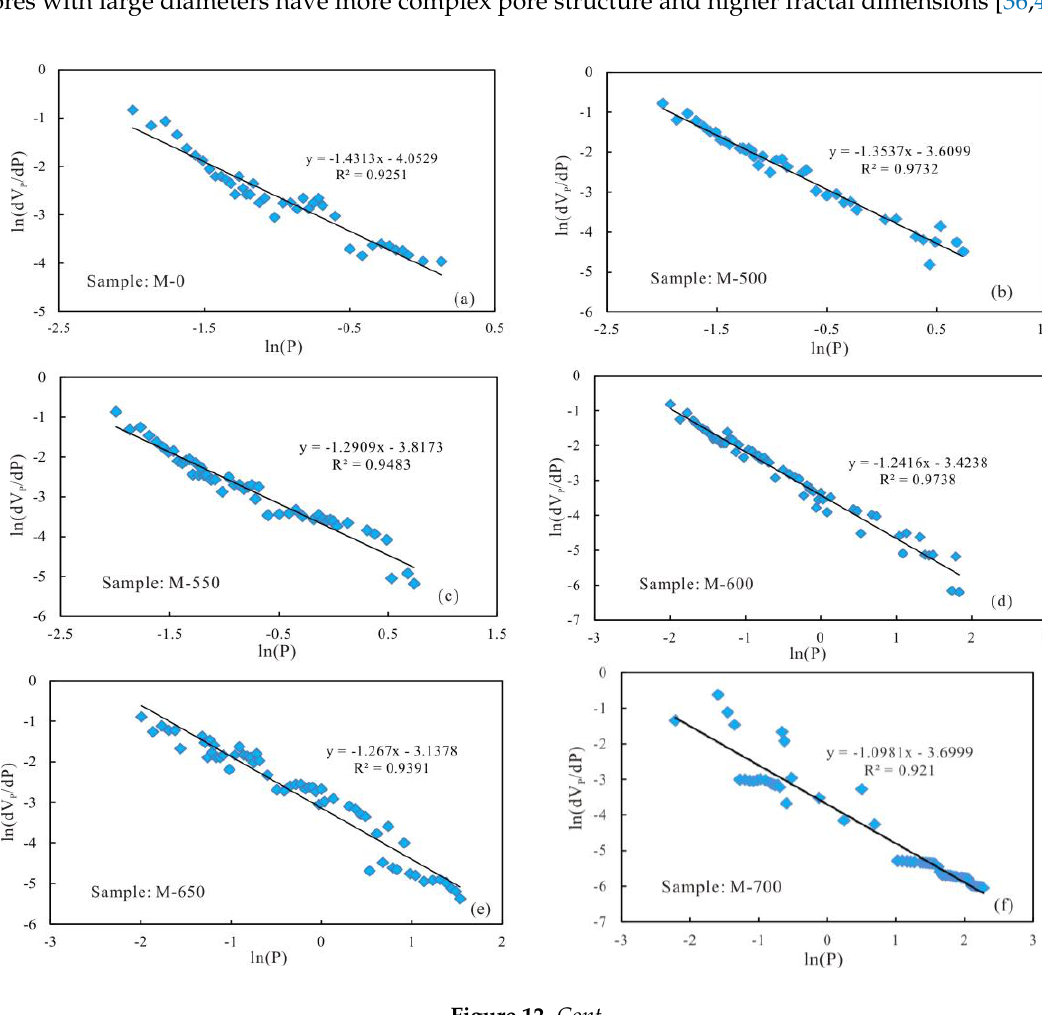
Figure 11. Plots of ln(V) vs ln(ln( P 0 / P )) reconstructed from the N 2 adsorption isotherms: ( a ) The initial sample M-0, ( b ) sample M-500, ( c ) sample M-550, ( d ) sample M-600, ( e ) sample M-650, ( f ) sample M- 700, ( g ) sample M-700.